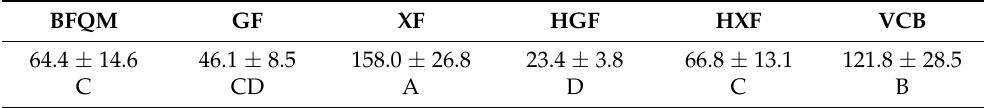
Table 3. Means ± standard deviations in µ m for the effect of resin composite type on film thickness of the different resin composites.